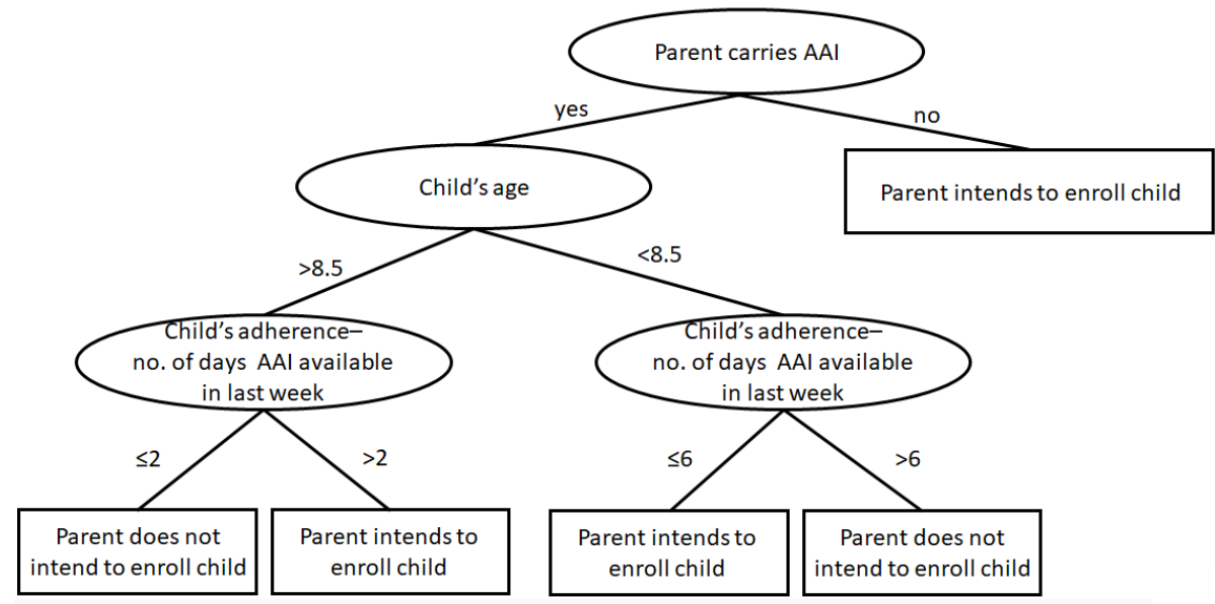
Figure 1. The influence of different independent variables on the parents’decision to enroll their children in the community.